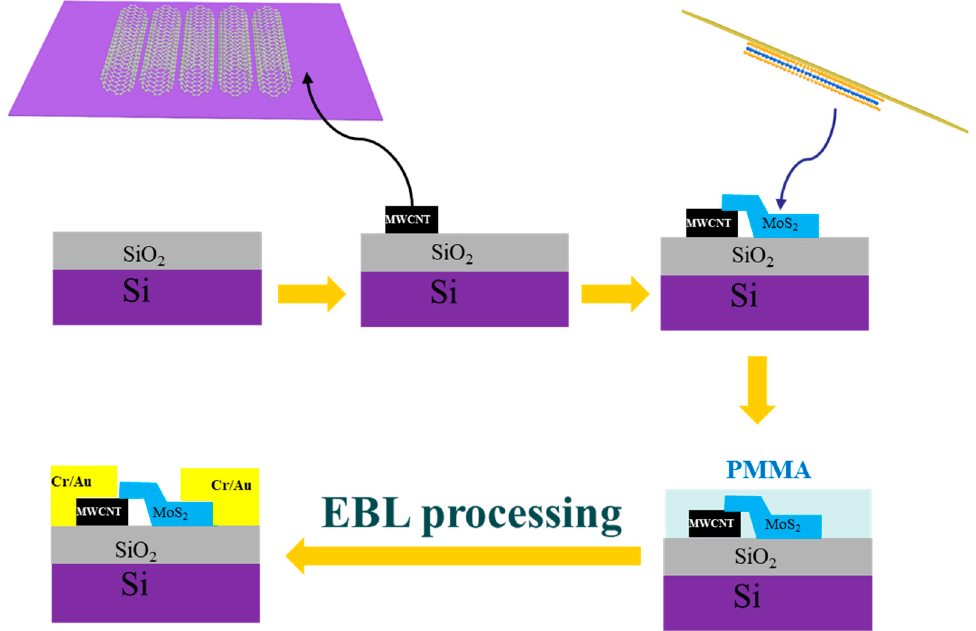
Figure 2. Schematic diagrams depicting the fabrication procedure for lateral vdW heterostructure.